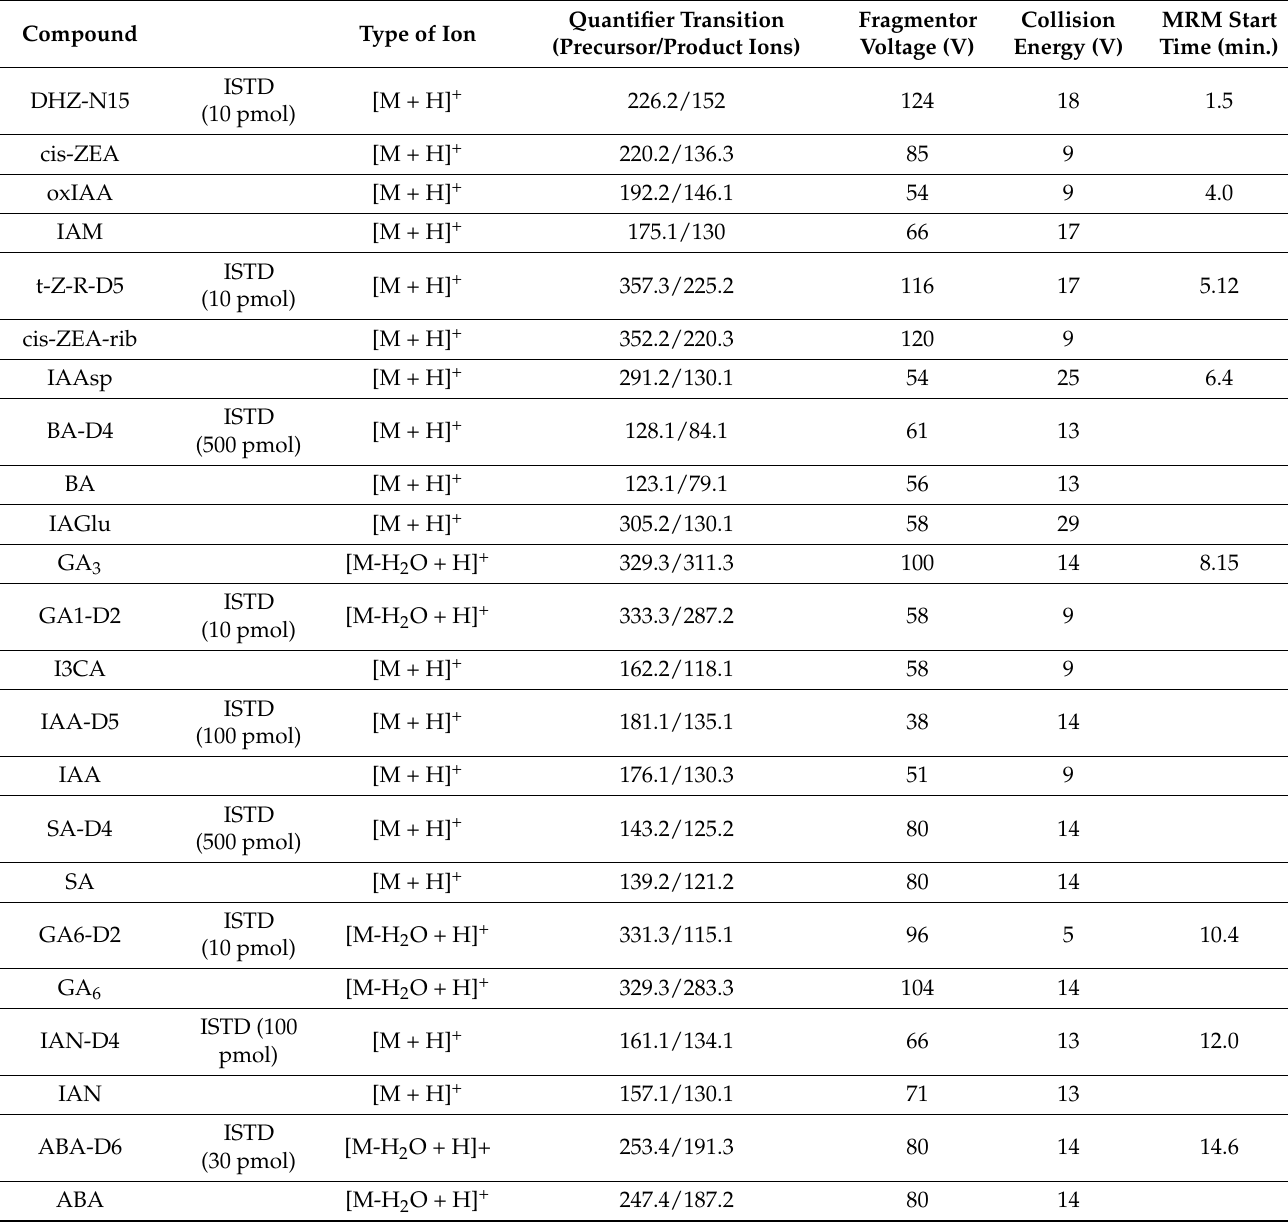
Table 1. The optimized mass spectrometry parameters that were used to quantify the phytohormones. The following conditions were optimal for the analyses: capillary voltage 4 kV, gas temperature 350 ◦ C, gas flow 12 L/min and a nebulizer pressure of 35 psi. The measurements were performed using multiple reaction monitoring (MRM) in a positive polarity. MassHunter software was used to control the LC-MS/MS system and data analysis. For the MRM parameters, a MassHunter Optimizer was used. The quantities of the internal standards (ISTD) are given in parenthesis. DHZ-N15 and t-Z- R-D5–internal standards for the cytokinins; GA1-D2 and GA5-D2–internal standard for gibberellins; for the other abbreviations, see Material and Methods Section